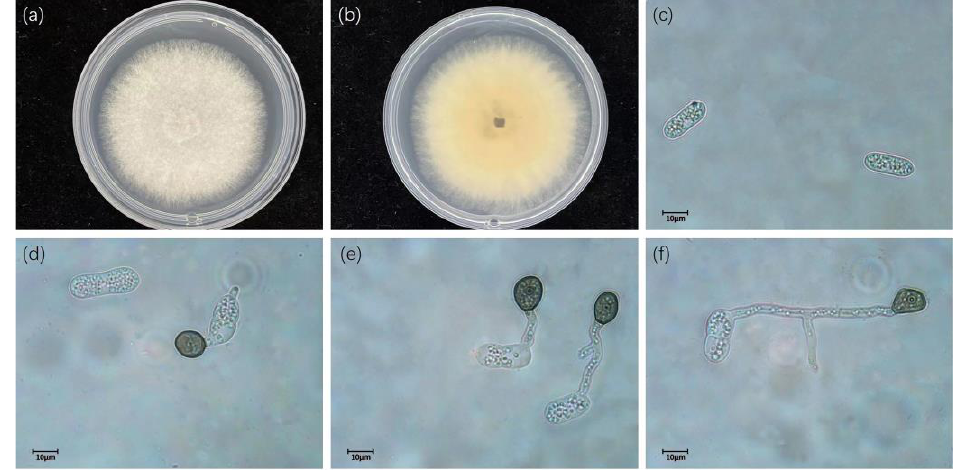
Figure 3. C. gloeosporioides (CQGX 24-1). ( a ) Colony on PDA. ( b ) Reverse side of the colony on PDA. ( c ) Conidia. ( d – f ) Appressoria. Scale bars = 10 µm.